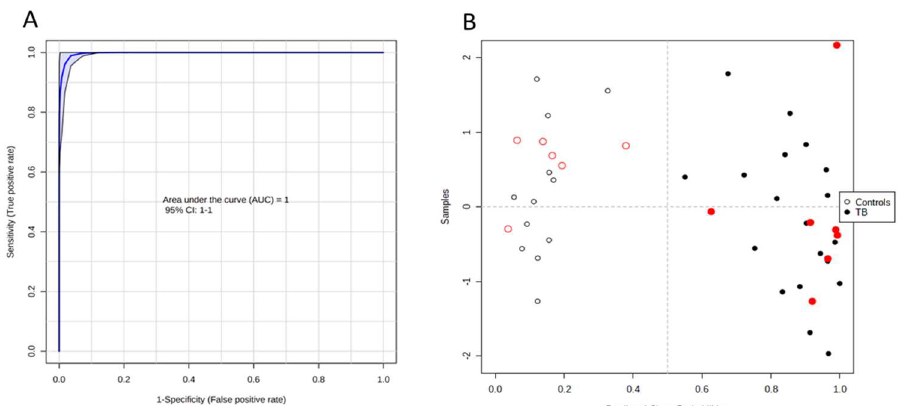
Figure 6. ROC analysis based on the metabolomic data. ( A ) The combination of five metabolites (9-